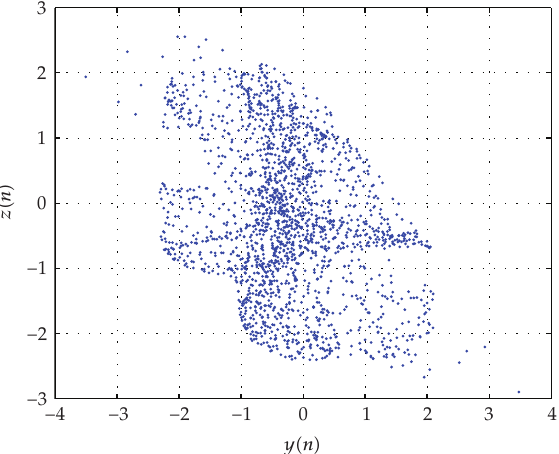
Figure 7: Phase portrait of the chaotic attractor (cid:5) y n ,z n (cid:6)